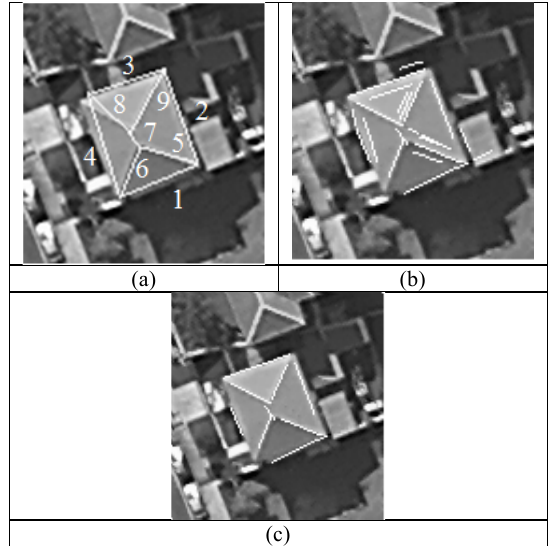
Figure 2. Test 1. (a) Projected ALS-derived roof polyhedron; (b) straight lines extracted from the image; and (c) group of straight lines obtained by the GA optimization